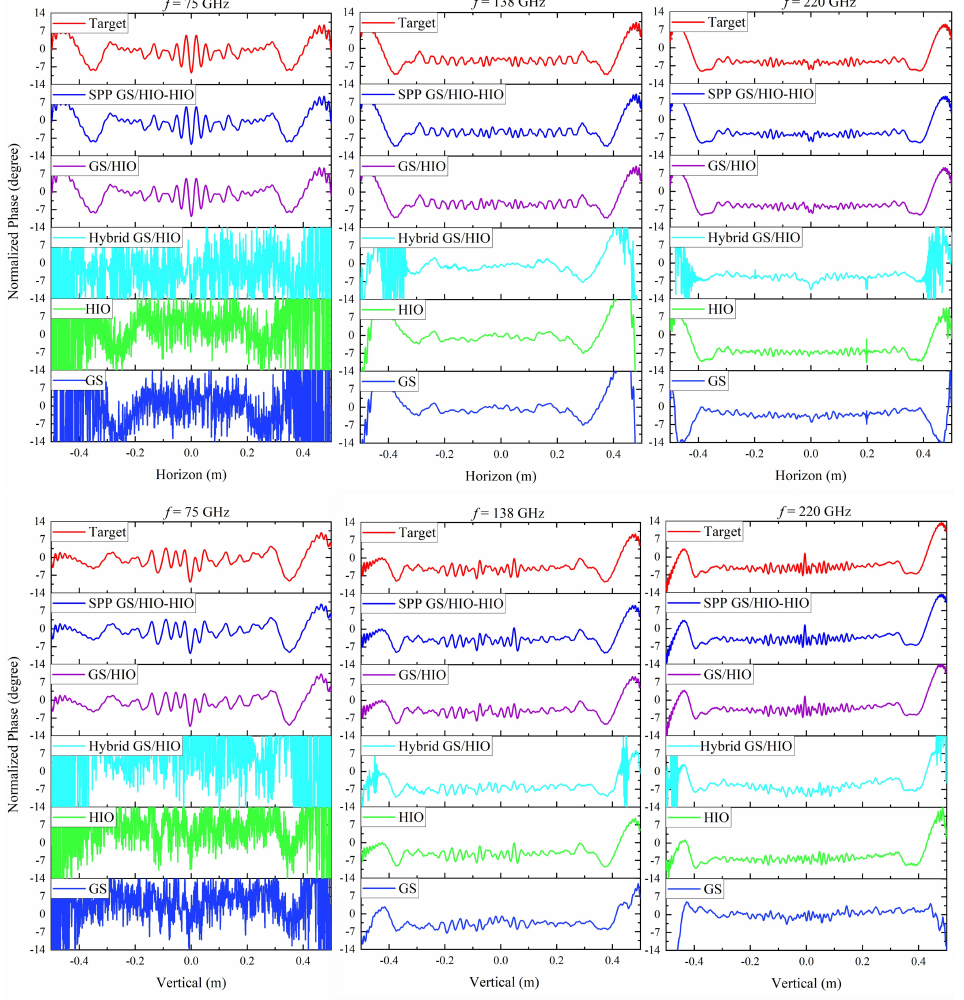
Figure 8. The comparison of target phase and phase retrieved by the algorithms at three different-